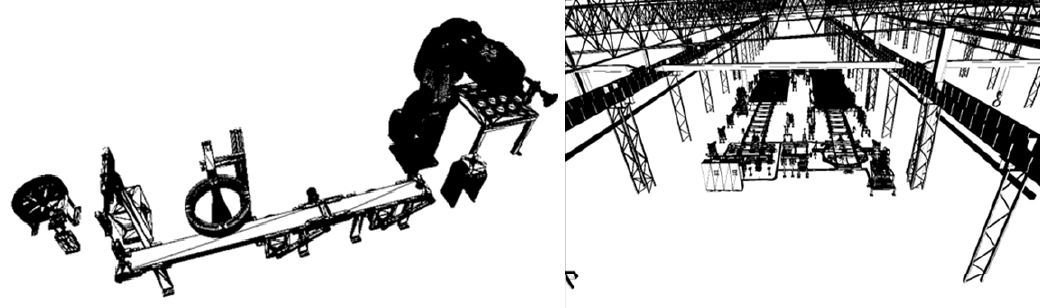
Figure 10. Values of index C 9 for models E 1 and E 2.